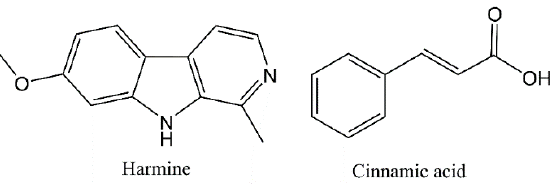
Figure 1. Chemical structure of harmine and cinnamic acid.